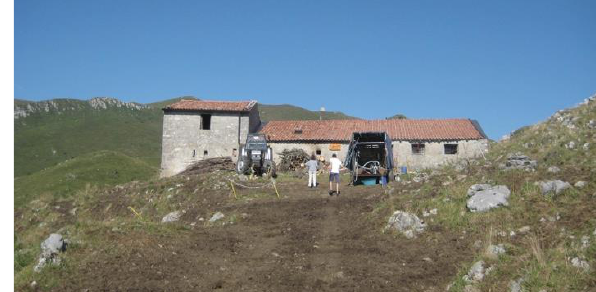
Figure 7. Farmhouse called ‘Stalletti alti’ in Tavernole sul Mella, Brescia (Italy).